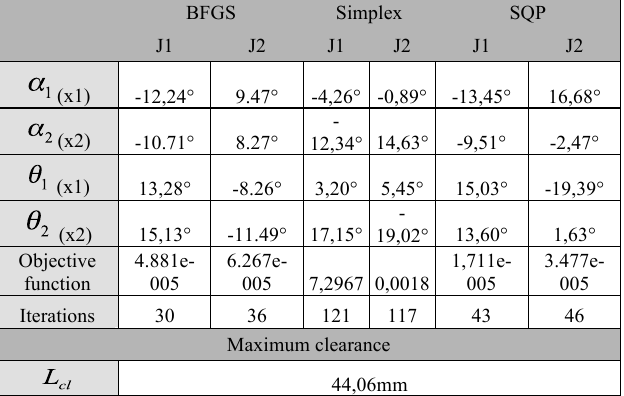
Table 2: Optimization results